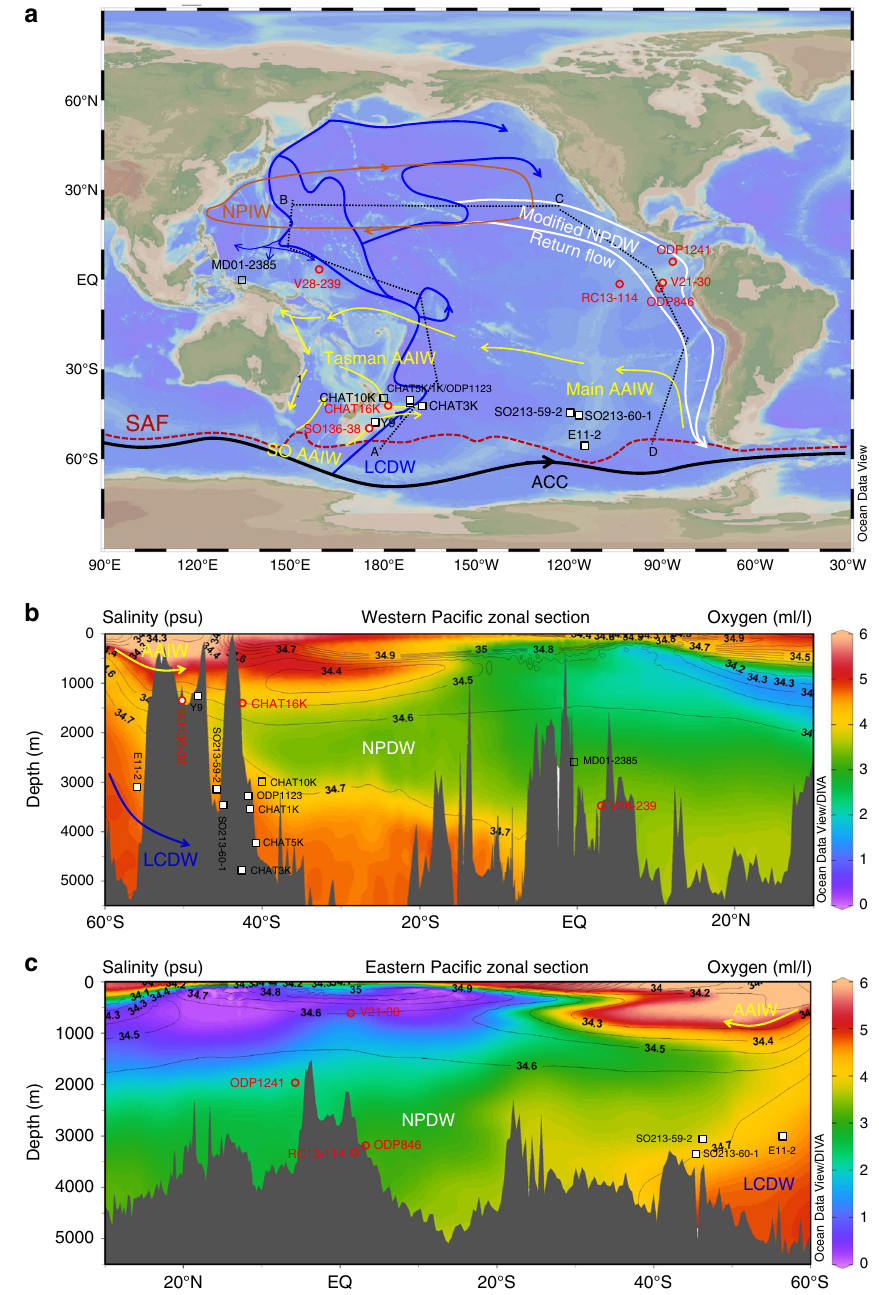
Fig. 1 Modern hydrography and core locations in the Paci fi c Ocean. a Map showing intermediate and deep water circulation and locations of the sediment cores from this study (red circles) and other Paci fi c sites (black squares) for comparison (Site locations and sources please refer to Supplementary Table 1). White fi lled symbols denote cores showing South Paci fi c-regime Nd isotope evolution patterns, while the open symbols represent cores showing North Paci fi c-regime patterns (see text). SAF: Subantarctic Front, ACC: Antarctic Circumpolar Current, LCDW: Lower Circumpolar Deep Water, AAIW: Antarctic Intermediate Water, NPDW: North Paci fi c Deep Water, NPIW: North Paci fi c Intermediate Water. b Western Paci fi c zonal section of dissolved oxygen (colour) and salinity (contours) along the dark grey dotted line from A to B in Map a . c Eastern Paci fi c zonal section of dissolved oxygen (colour) and salinity (contours) along the dark grey dotted line from C to D in Map a . Note that the three cores from the Central South Paci fi c are included in both sections solely on their latitudes and depths. Figures created using Ocean Data View Software